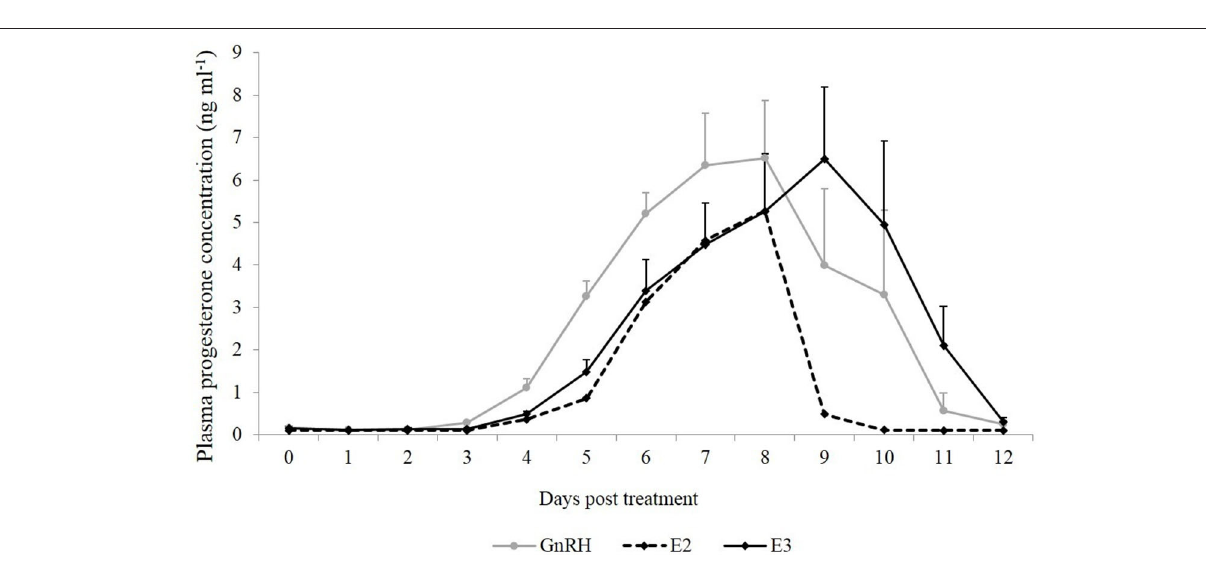
FIGURE 2 | Mean plasma progesterone concentration (ng ml − 1 ) from the day of treatment (Day 0) until Day 12 post-treatment. Gray line: animals treated with Buserelin, analog of GnRH ( n = 6), black line: animals treated with a dose of 1.6mg of estradiol-17 β ( n = 6), and dotted line represents the only llama that ovulated in response to a dose of 1.0mg of estradiol-17 β